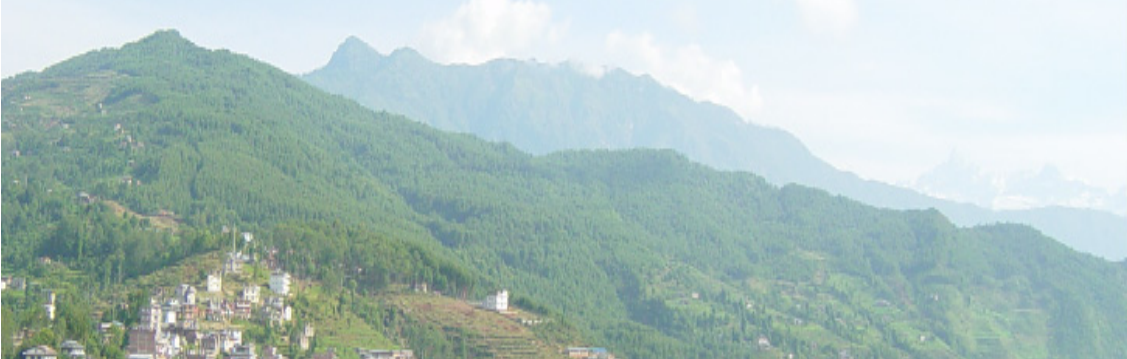
Figure 2. Overstocked underutilized forests were established in community pasturelands with the Figure 2. An overstocked and underutilized forest (Khorthali Charikot). An international aid technical advice and financial support of the Swiss Development Agency.